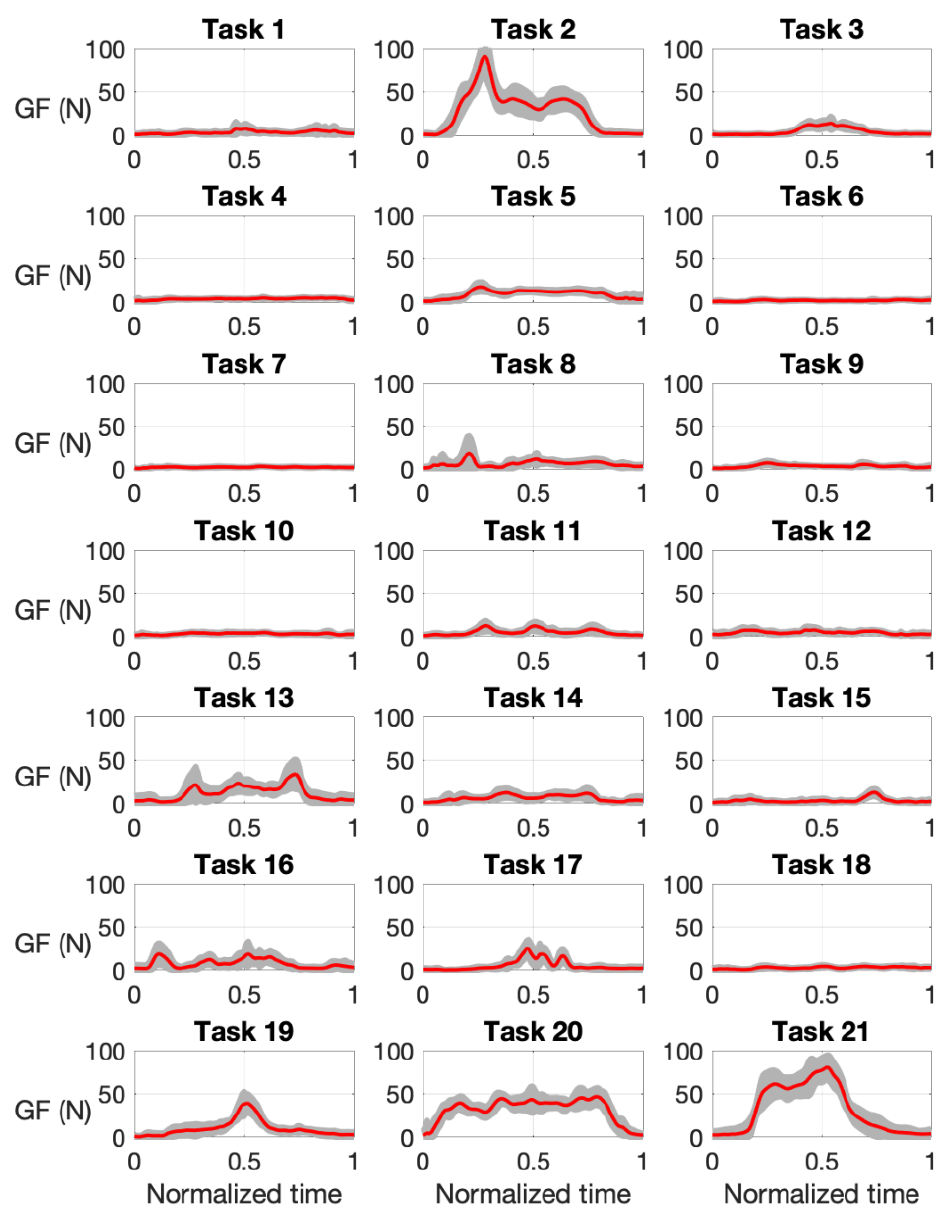
Figure 7. Mean grip force (GF, in N) versus normalized time for the different 21 tasks with curves for each subject scaled for a common mean GF in each task. Shaded areas show the standard devi- ation.